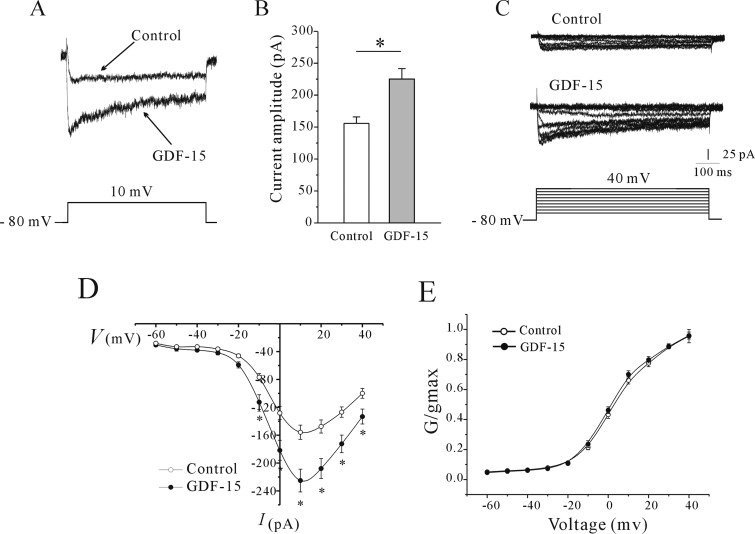
Effect of GDF-15 on ICa amplitude and steady-state Ca2+ channel activation(A) Representative traces of control and GDF-15-treated CGNs. ICa was elicited by depolarization to 10 mV from a holding potential of −80 mV. (B) Statistical analysis of the effect of GDF-15 on ICa amplitude. Results are means±S.E.M. *P<0.05 for two groups connected with a straight line. (C) Representative traces obtained with a steady-state voltage protocol of control and GDF-15-treated CGNs. ICa was elicited by 200-ms depolarizing pulses from a holding potential of −80 mV to between −60 and +40 mV in 10-mV steps at 10-s intervals. (D) Voltage-dependent activation curves of ICa. *P<0.05 compared with corresponding control. (E) Steady-state activation curves of ICa obtained by plotting normalized conductance as a function of command potential. Data points were fitted using the Boltzmann function. Results are means±S.E.M.